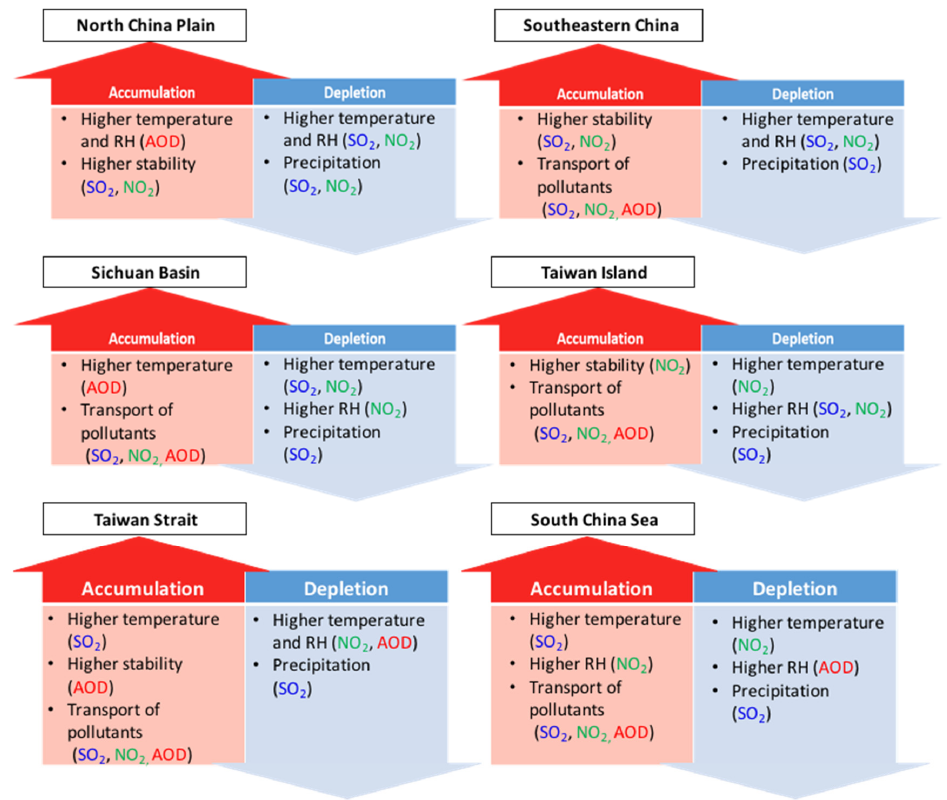
Figure 13. Summary of correlations between pollutants and meteorological conditions for six monitoring regions. When the effect of meteorological factor leads to the accumulation/depletion of pollutants, it is indicated by the red/blue arrow. Additionally, the effect of meteorological factor could be only significant on certain species of pollutant, which is shown within the brackets and is further highlighted by blue, red, and green color for SO 2 , NO 2 , AOD, respectively.